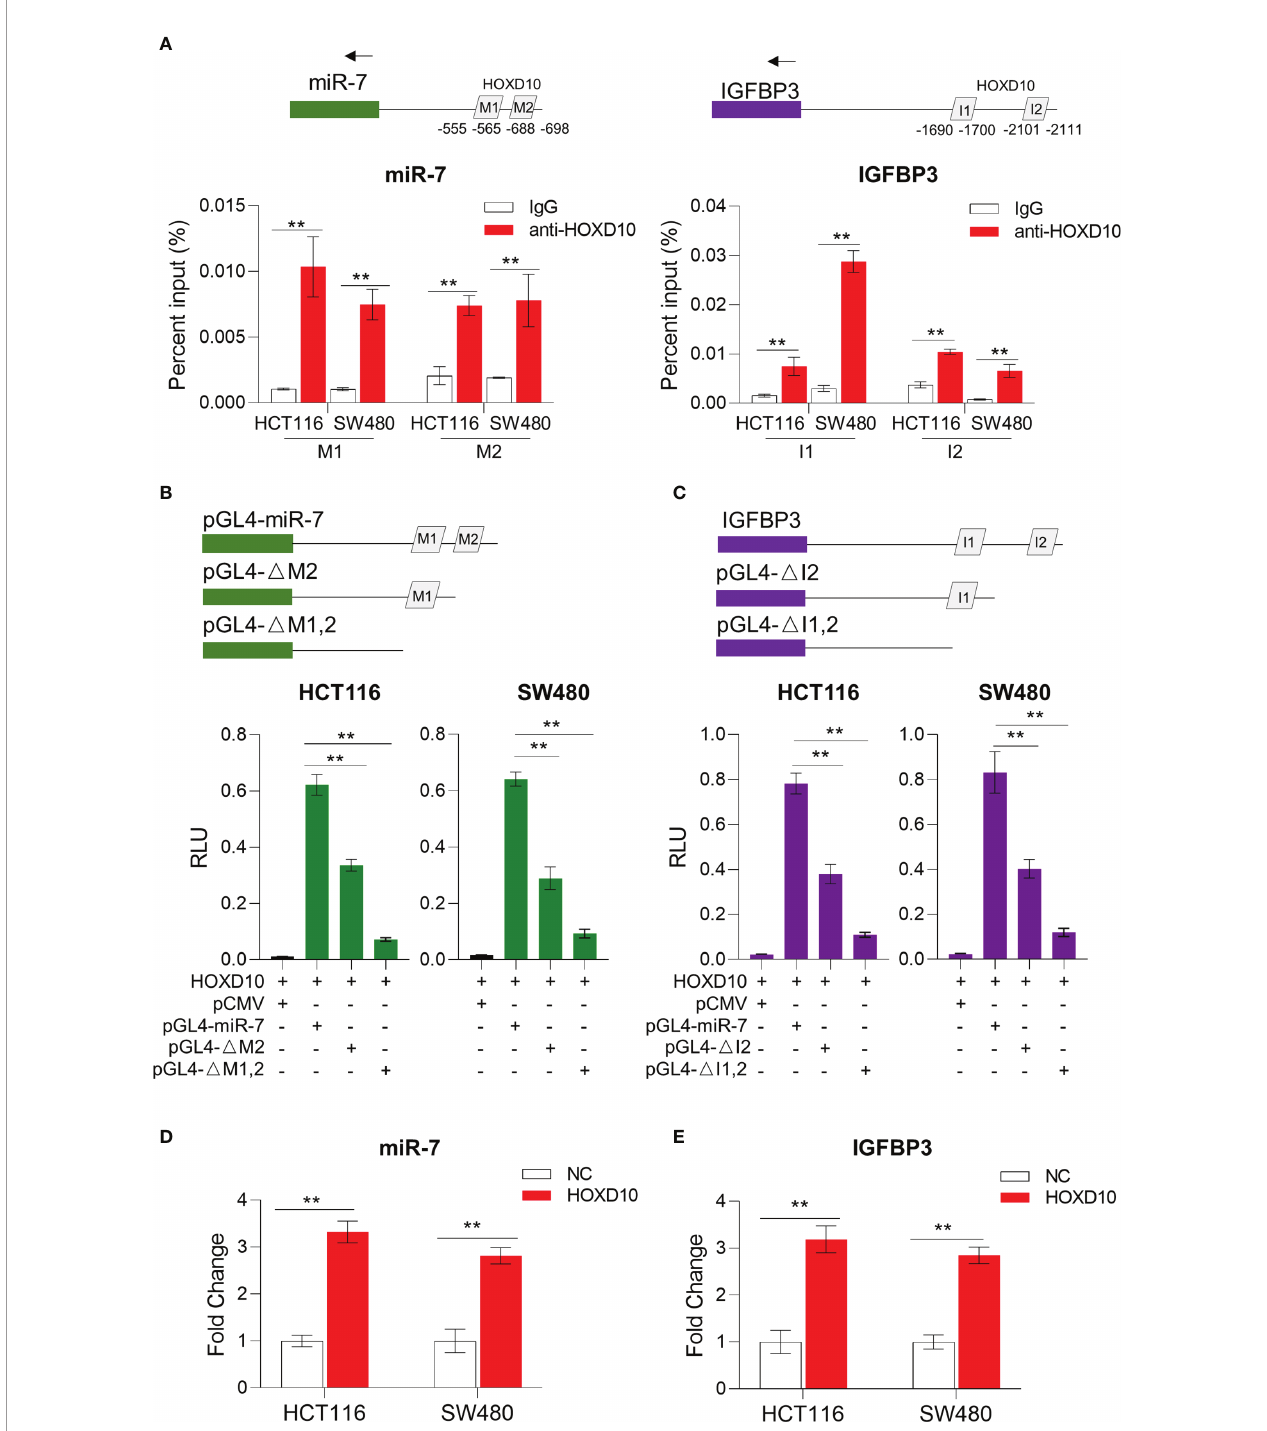
FIGURE 4 | HOXD10 regulated miR-7 and IGFBP3 in a promoter-dependent manner. (A) Chromatin immunoprecipitation quantitative PCR (ChIP-qPCR) assay revealed that HOXD10 binds to the miR-7 and IGFBP3 promoter region in HCT116 and SW480 cells. ** p < 0.01 (independent t -test comparing IgG control and HOXD10 pull-down). (B, C) Luciferase reporter assay demonstrated the effect of transient expression of HOXD10 on either wild or deleted mutant promoter of miR-7 and IGFBP3. ** p < 0.01 (independent t -test). (D, E) Relative expressions of miR-7 and IGFBP3 in HOXD10 -expressing cells and control cells by qPCR. ** p < 0.01 (independent t -test comparing control and HOXD10 -expressing